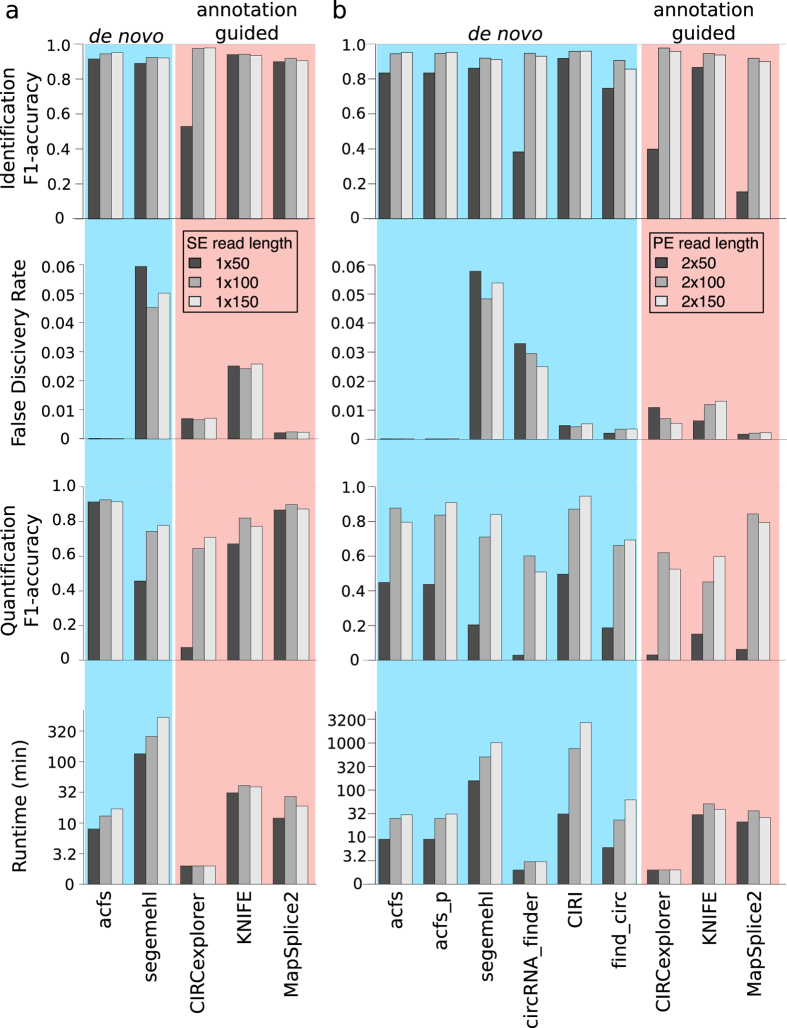
Benchmark of acfs using simulated data emphasizes the importance of accurate BSJ identification.(a) Benchmark of all five tools supporting SE datasets in terms of identification accuracy, false discovery rate, quantification accuracy and runtime. (b) Benchmark of acfs with seven state-of-the-art tools on PE datasets. The color of the bars (black, grey and white) represents reads of different length (50, 100, 150 nt).